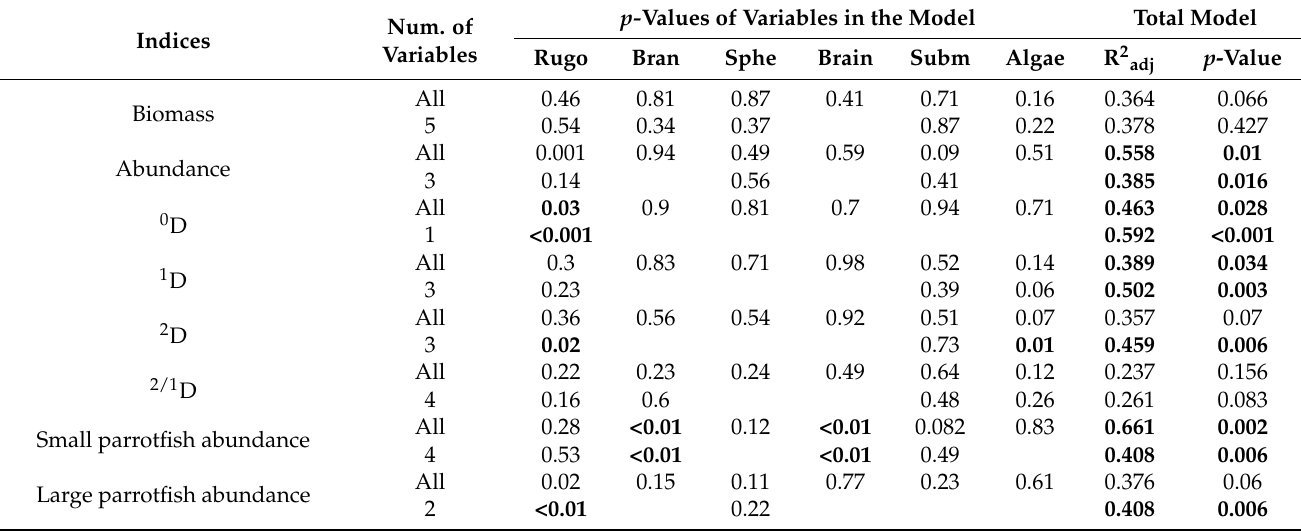
Table 1. Habitat structure drivers of reef fish diversity and abundance at Serranilla; regressions of fish assemblage measures against reef habitat measures. The results shown within each pair of lines are for (upper line) linear models using all potential explanatory variables and (lower line) for the best fit model selected using AICc criteria. p -values are shown for the adjusted R 2 estimates as well as for the entire